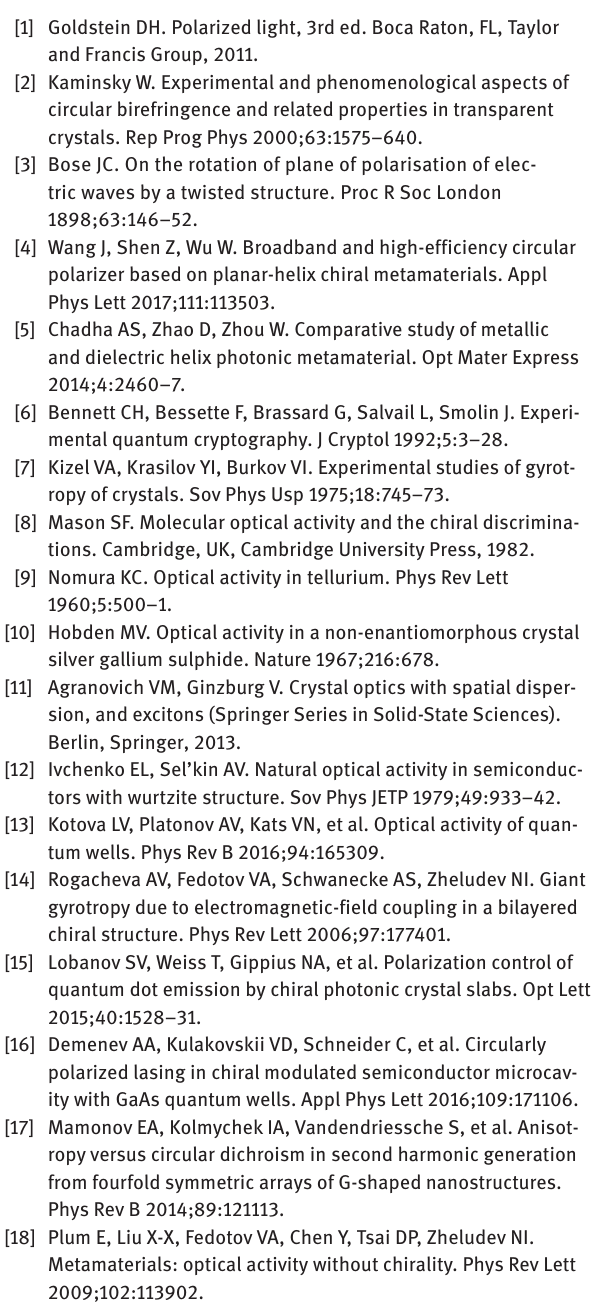
Figure 6D–F show the spectral dependence of the PL circular polarization degree defined